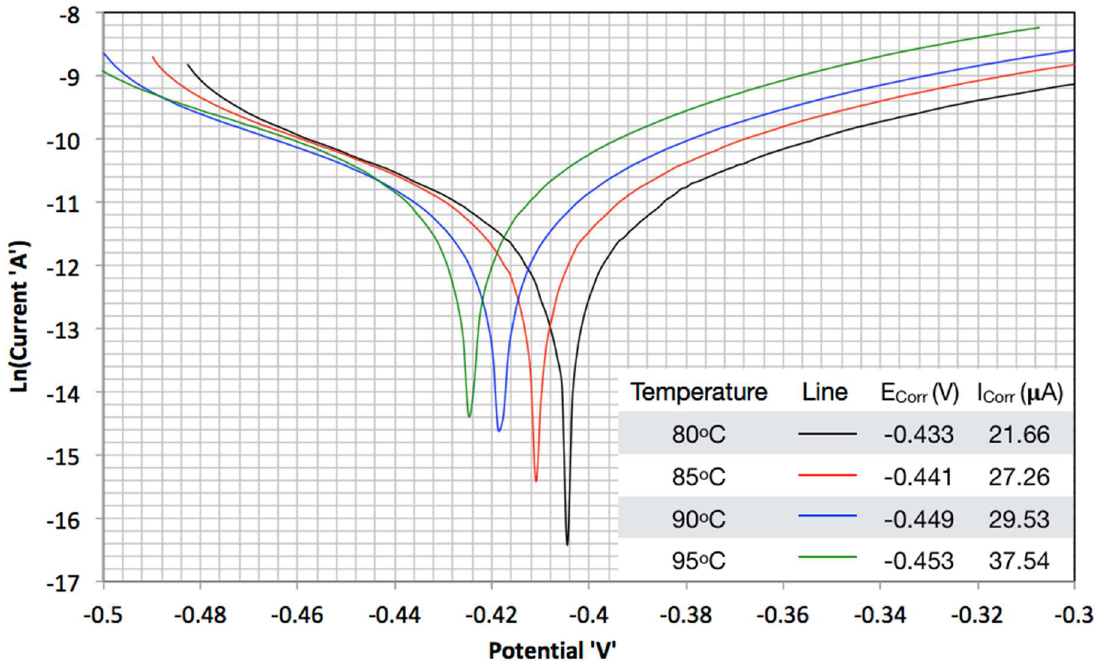
Figure 3. Tafel curves of pure [bmim][MS] with CO 2 at different temperatures. Scan rate = 1 mV/s. Fitted results for corrosion rates and potential are provided in the table.